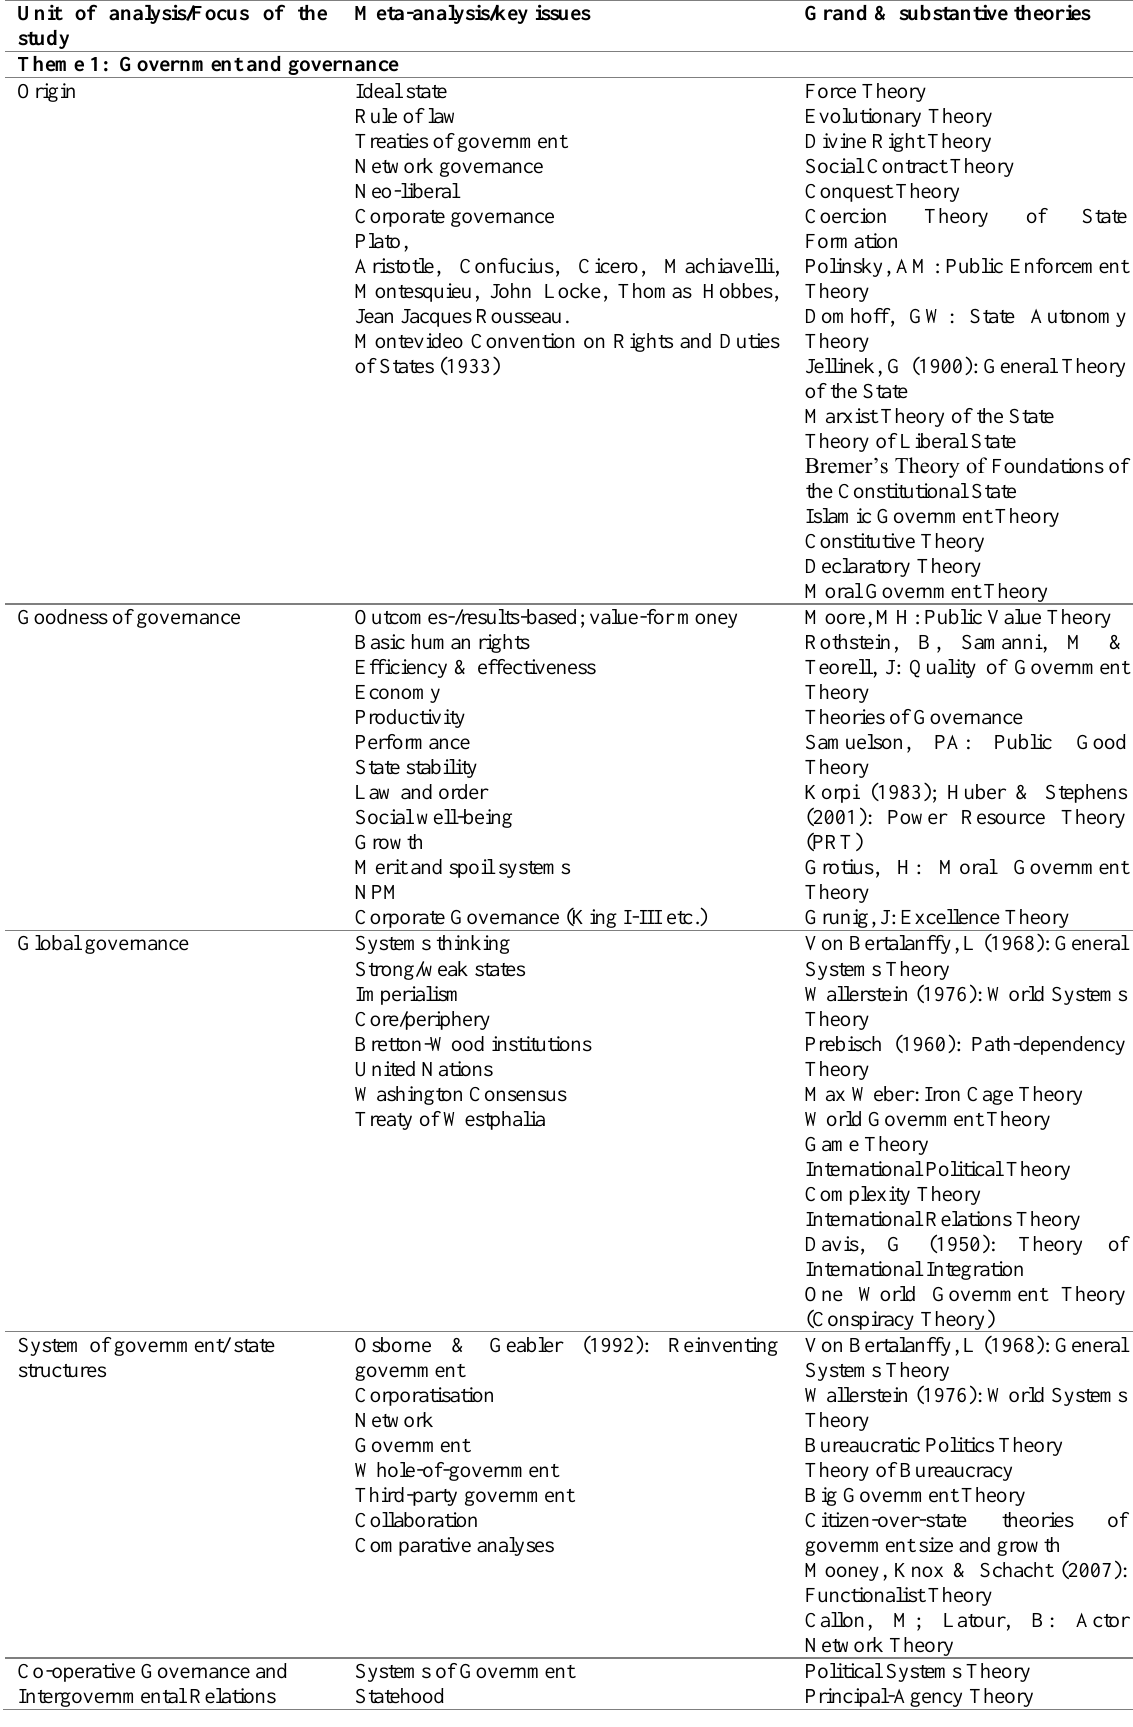
Table 1: Van der Waldt’s (2017) Core theories for Public Administration